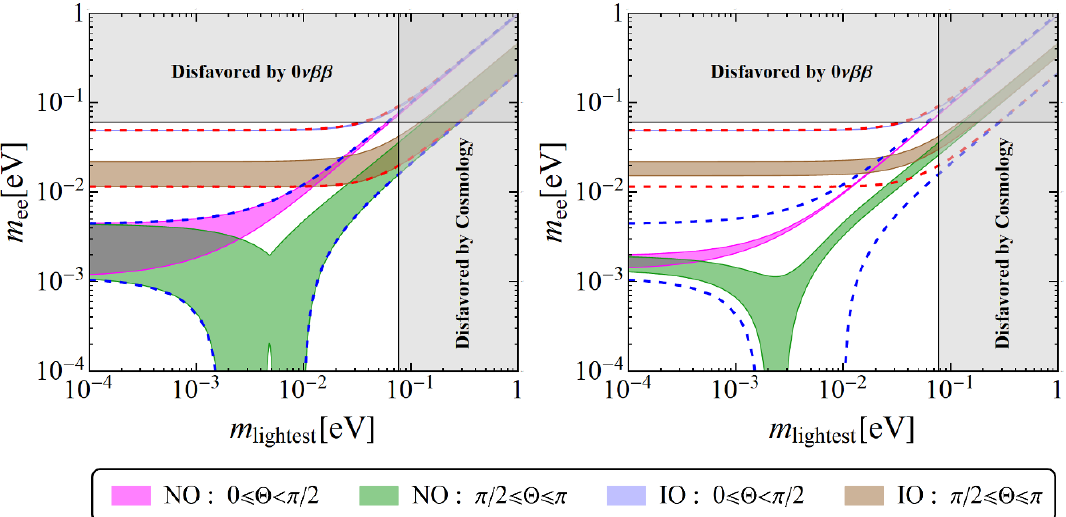
Figure 13 . The same as (cid:12)gure 11 for the generalized (cid:22) (cid:0) (cid:28) re(cid:13)ection. The CP label (cid:2) is free on the left panel, and we (cid:12)x (cid:2) = (cid:25)= 6 and (cid:2) = 5 (cid:25)= 6 on the right panel. Notice that the IO: 0 (cid:20) (cid:2) (cid:20) (cid:25) region (cyan) is very narrow and is close to the maximum m ee for IO. This region can be tested very soon in neutrinoless double beta decay experiments.